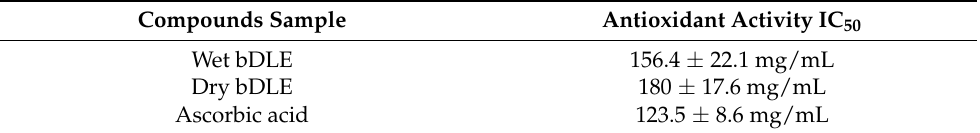
Table 4. Antioxidant capacity of wet and dry bDLE.